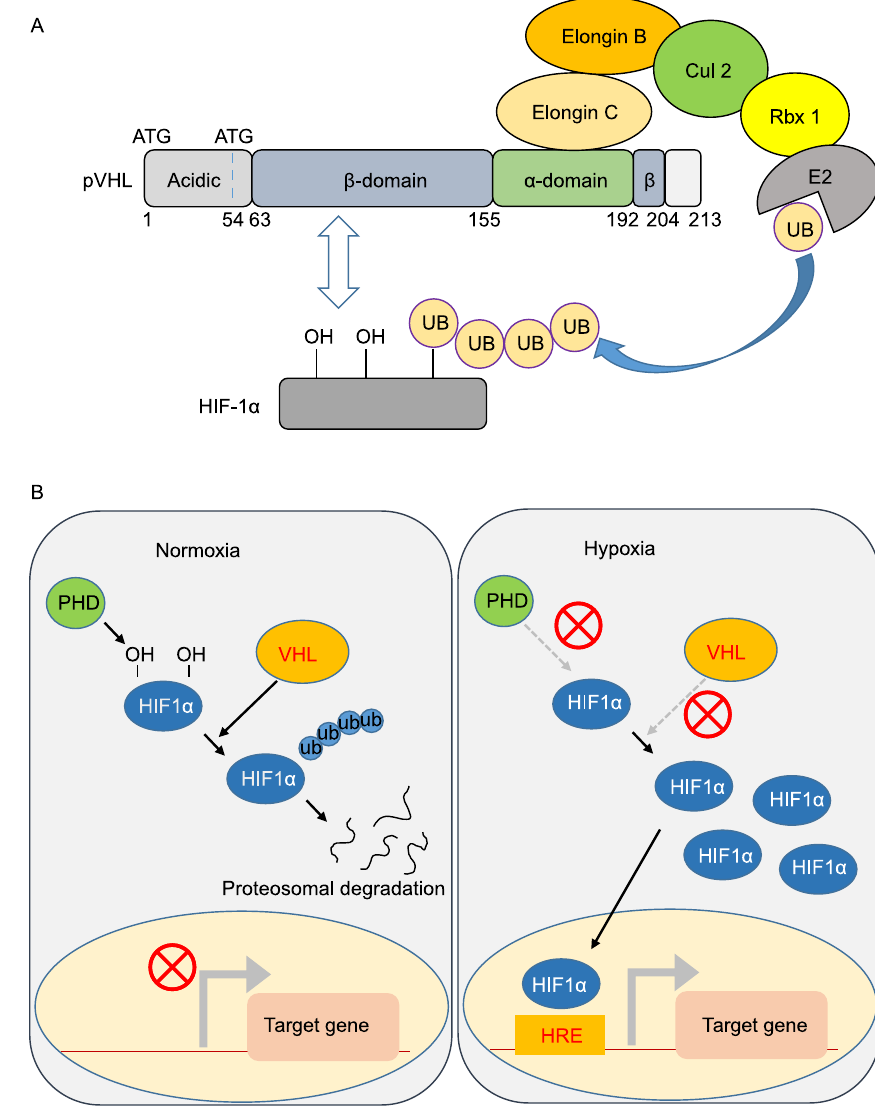
Figure 1. VHL-HIF path- way. (A)